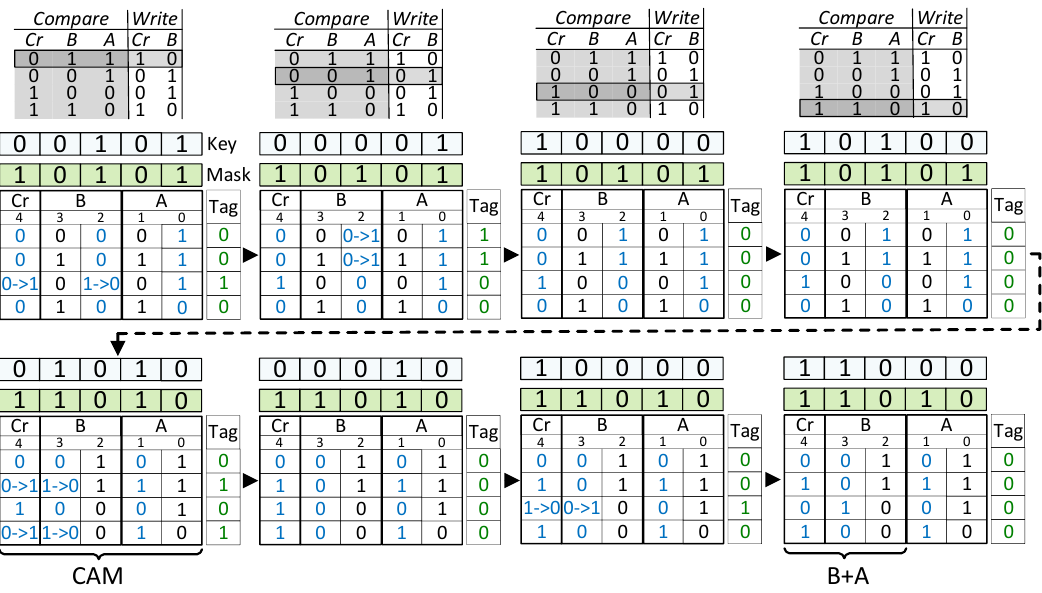
Figure 2. The sequence of compare and write operations are shown for a complete vector addition operation on 2-bit, 4 × 1 vector pairs of A (column 1-0), and B (column 3-2). The highlighted lookup table (LUT) entry shows the applied key values to the corresponding content addressable memory (CAM) columns specified by the mask register, and the arrows indicate the